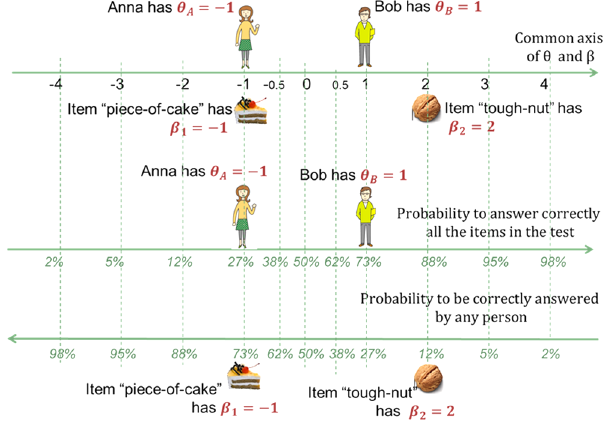
FIG. 2. The logit-unit axis simplifies the predictions with Rasch calibrated tests. Two persons, Anna and Bob, and two items, piece of cake and tough nut, are shown. From each persons ’ location on the common logit axis at the top, we know that Anna has a lower probability than Bob to solve correctly any item. We know that Anna has a 50% chance to solve correctly the item piece of cake. We need Eq. (1) for calculating that Bob has an 88% chance to get piece of cake correctly, but only a 27% to solve tough nut. Anna ’ s chance with tough nut is of 4.74%. Alternately, we could refer to two separate probability axes going in opposite directions, one for persons and one for items. Instead of reading “ Bob ’ s ability is of 1 logit, ” one may prefer to read on the middle axis that “ Bob has a 73% chance to solve correctly all the items in the test ” . On the lower axis going from right to left, the probabilities to correctly solve the items are shown as percent- ages. An average person receiving the basic training in the field measured by the test has a probability of 73% to solve the item piece of cake but only of 12% to solve the item tough